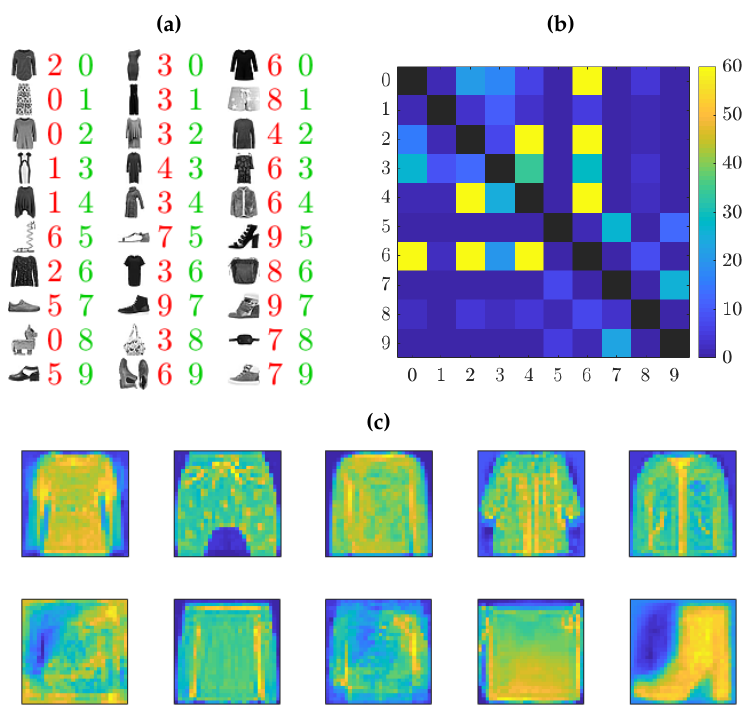
Figure 7. Fashion MNIST classification: ( a ) Misclassified images. ( b ) Histogram of misclassified images. ( c ) Visualizations of the learned